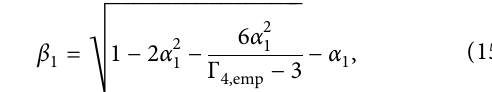
Table 1: The minimum and maximum values of Γ company’s trajectories in ( α